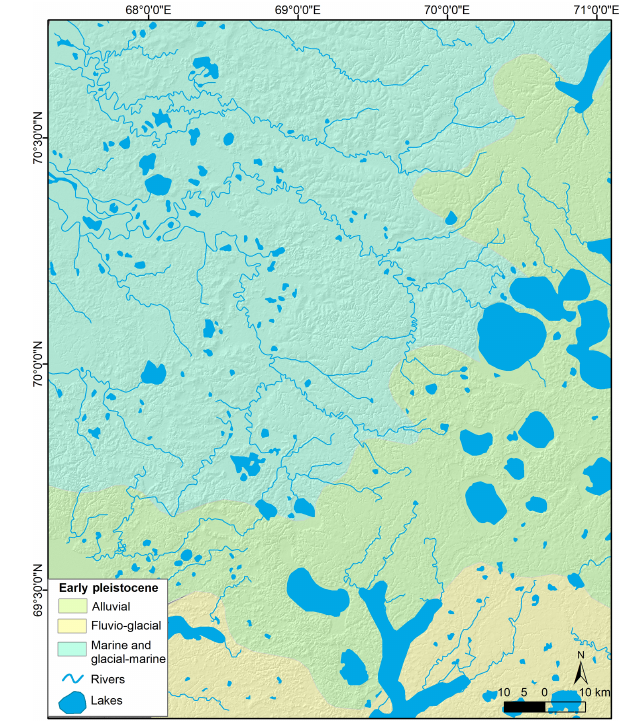
Figure 5. Geology map of the study area. The map is modified after FAO project defined geology map of the western